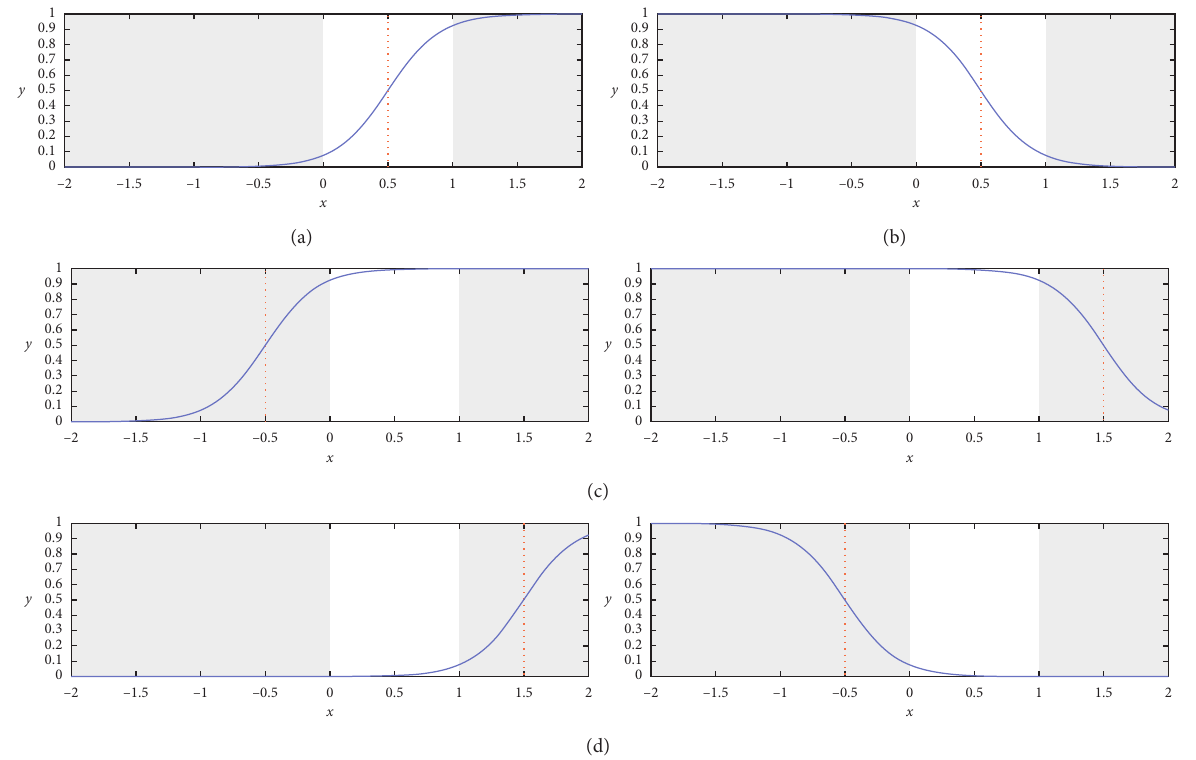
Figure 3: Six function cases of the synaptic layer. (a) Direct connection. (b) Inverse connection. (c) Constant-1 connection (c Constant-0 connection (d 1 , d 2